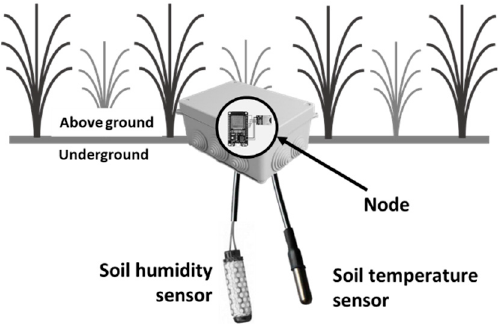
Figure 5. Design example of the soil monitoring node.